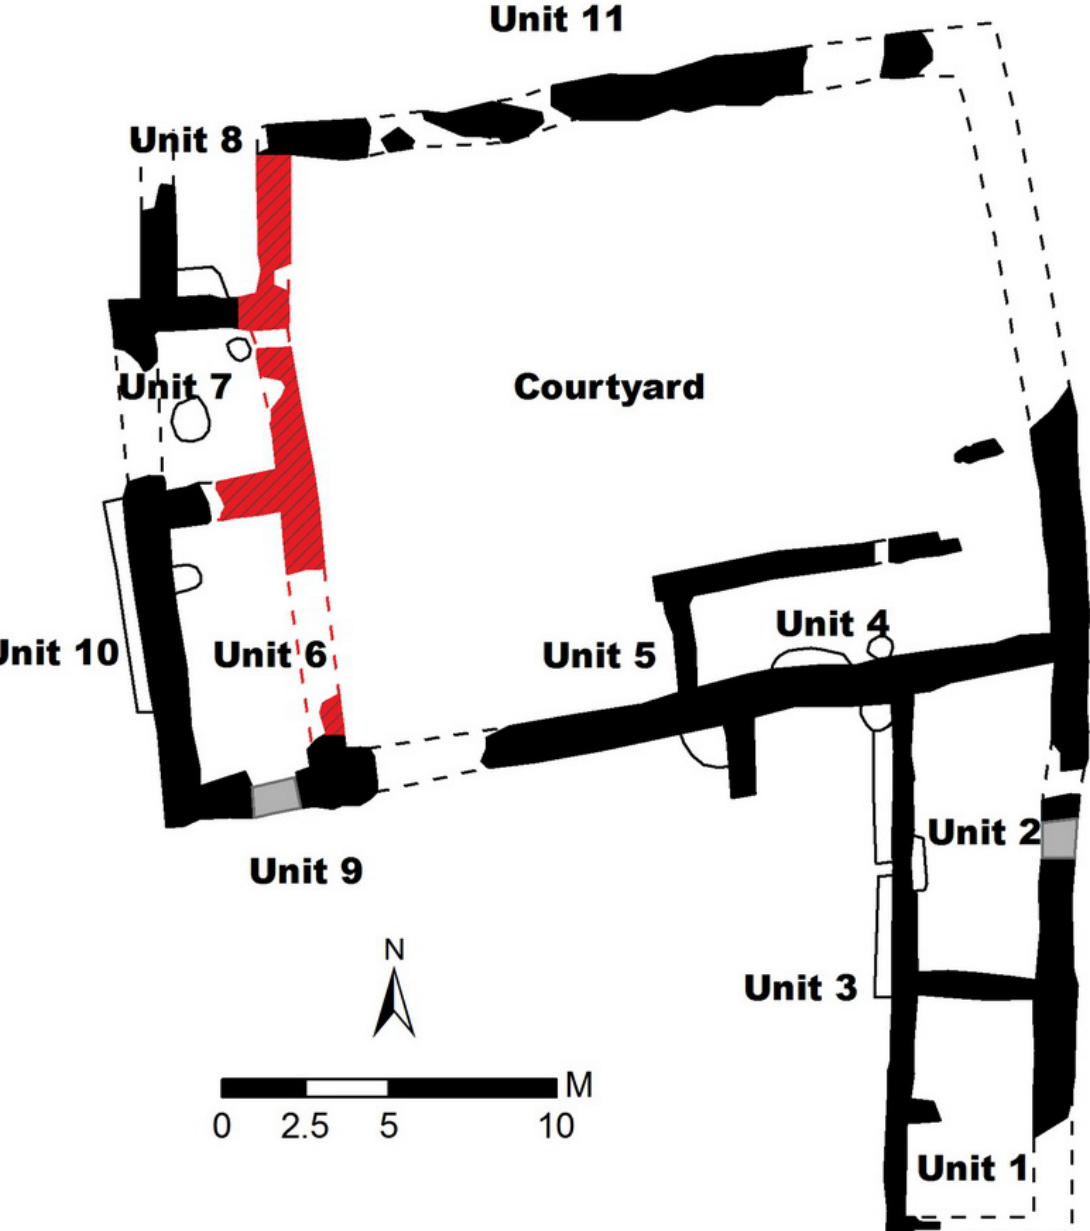
Figure 5. Schematic plan of Fazael 2. The eastern walls of Units 6-8 covered by an upper floor level are shown in hatched